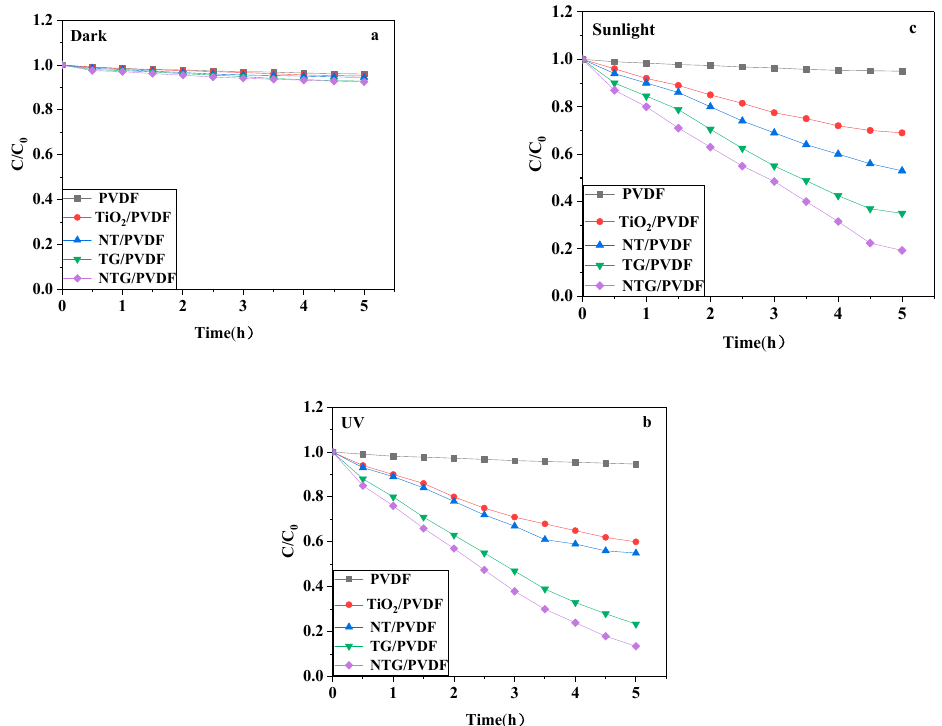
Figure 9. The photodegradation of MB by the membranes in ( a ) darkness ( b ) under ultraviolet light and ( c ) under and ( c ) under sunlight.